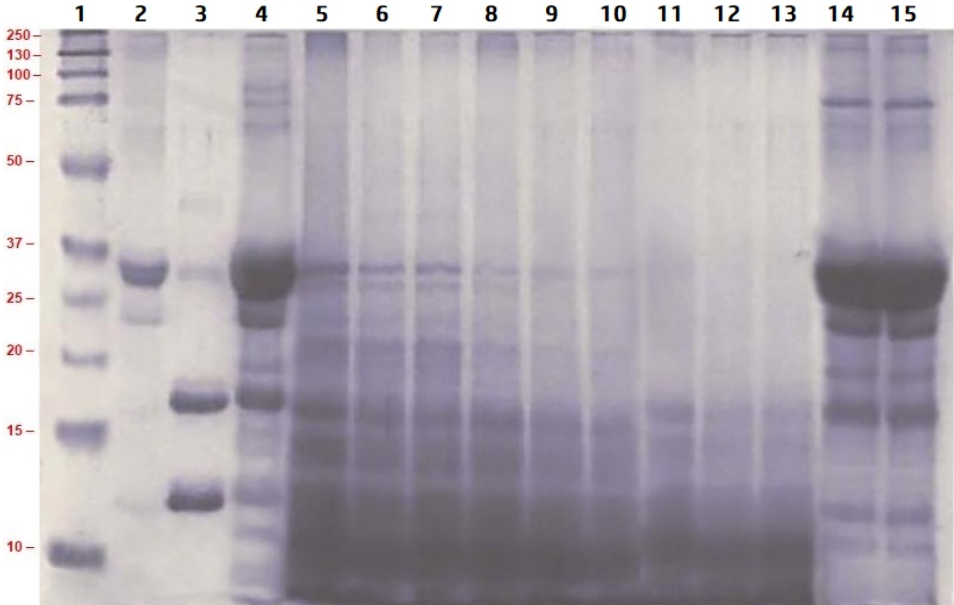
Figure 4. SDS-PAGE image of proteins and peptides; lane 1: marker protein, lane 2: standard casein, lane 3: standard α -lactalbumin and β -lactoglobulin, lane 4: LMPC, lane 5: LMPC-T-0.008, lane 6: